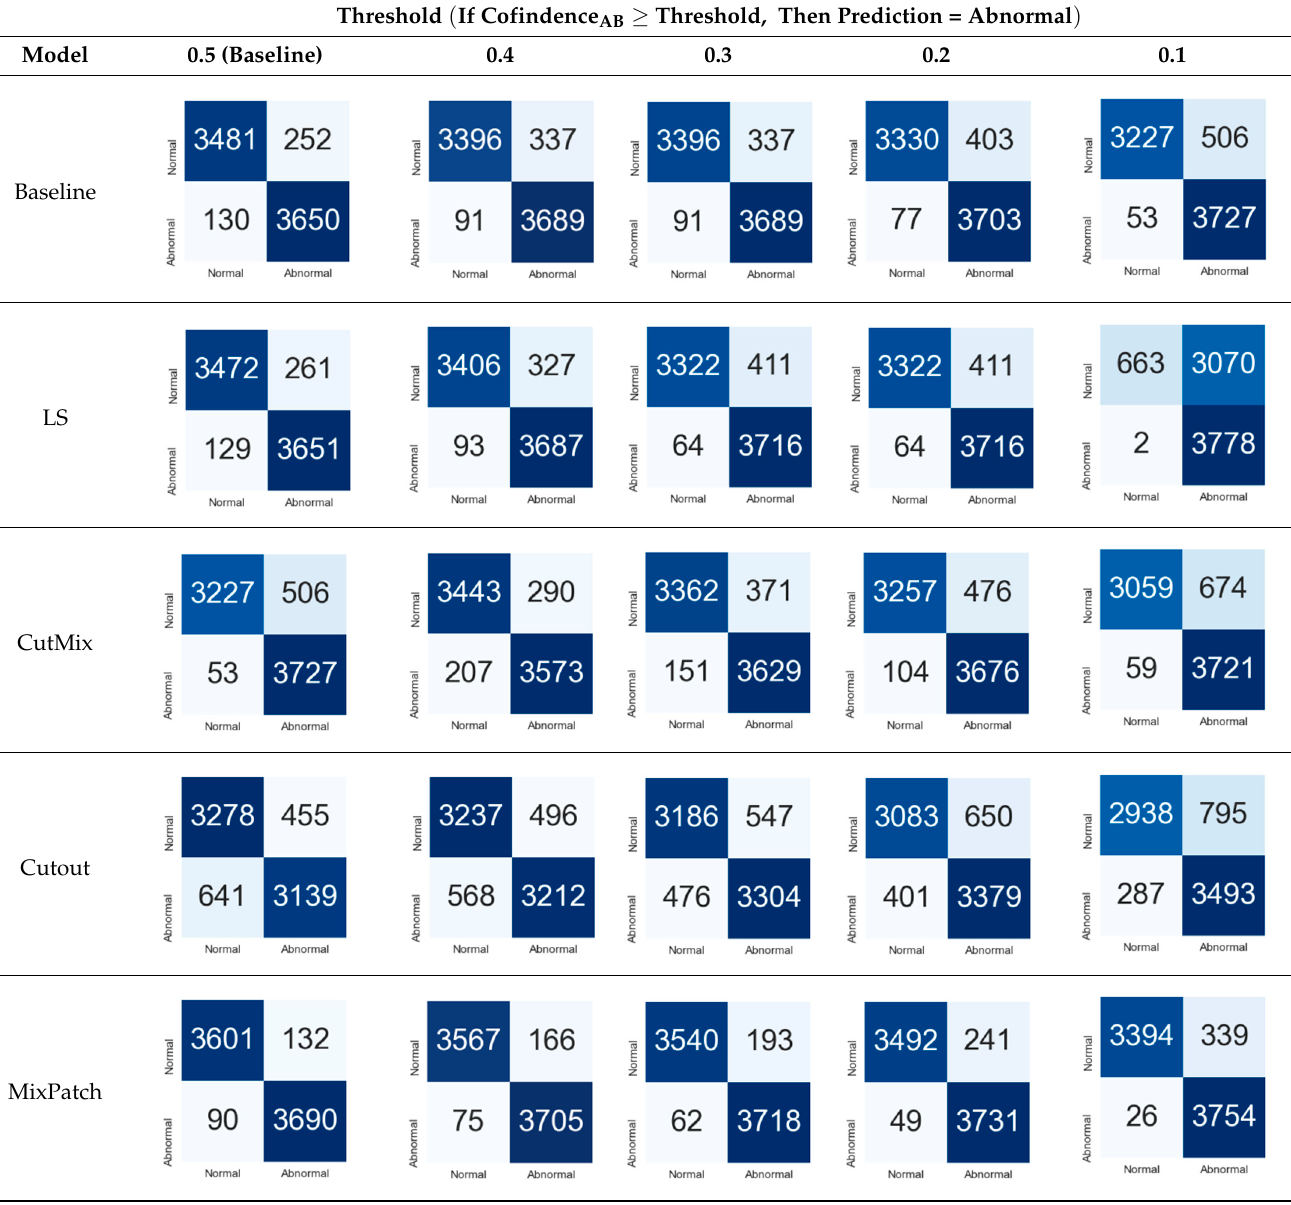
Table 7. Confusion matrix for each method with a threshold approach (X = prediction, Y = true).